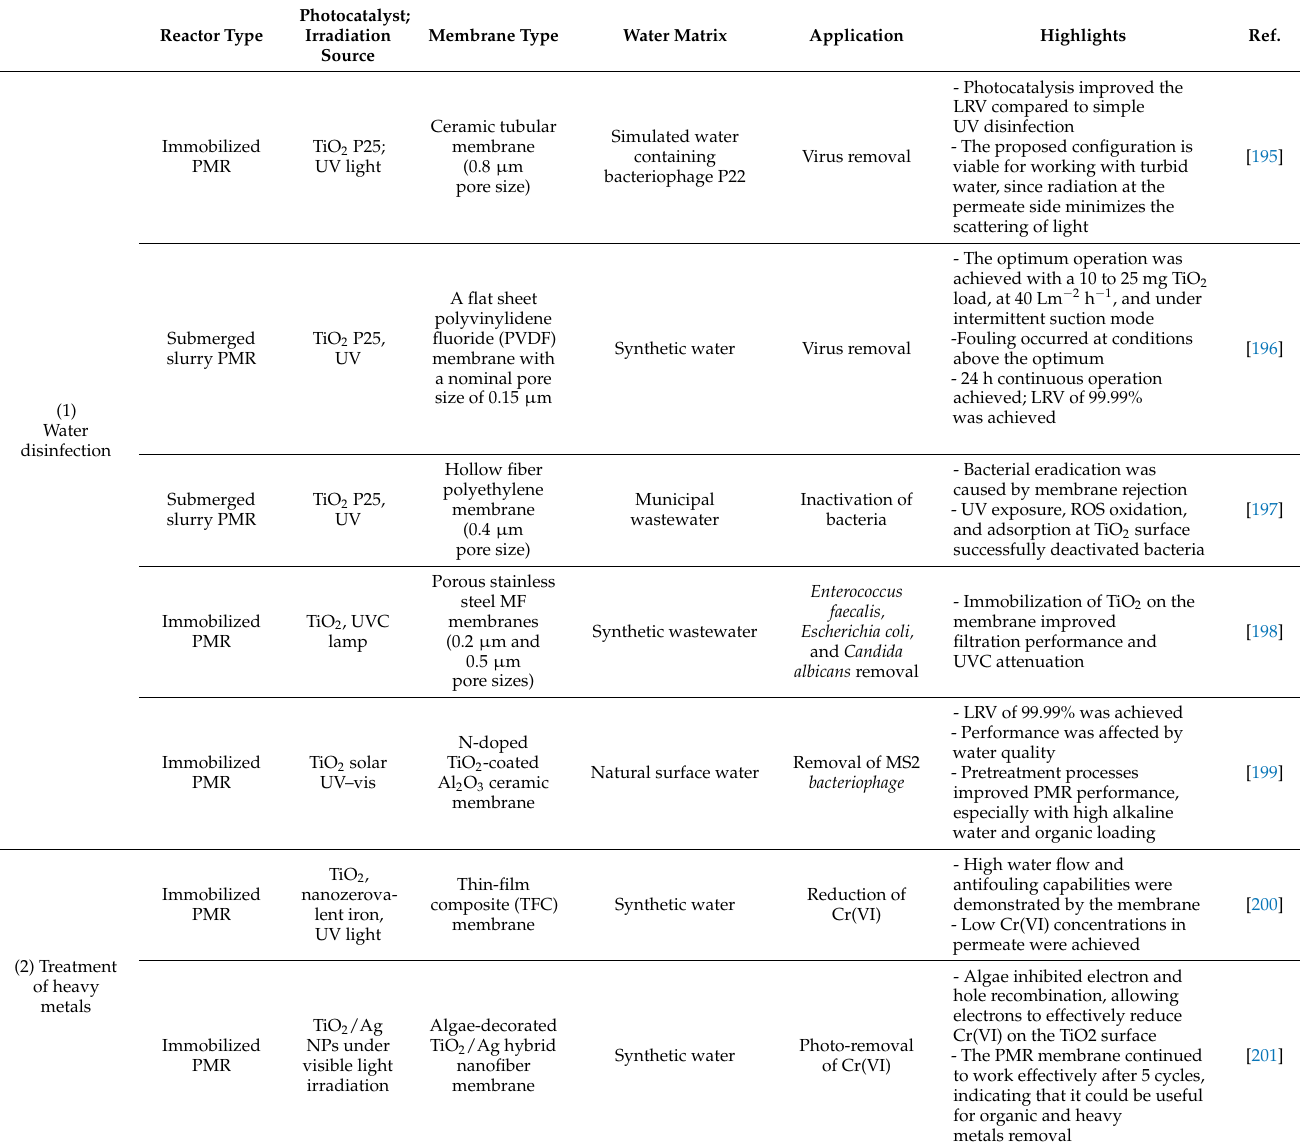
Table 3. A summary of various applications of PMRs in water disinfection, heavy metal and wastew- ater reclamation, the removal of dyes, and oily wastewater treatment, as well as the treatment of pesticide